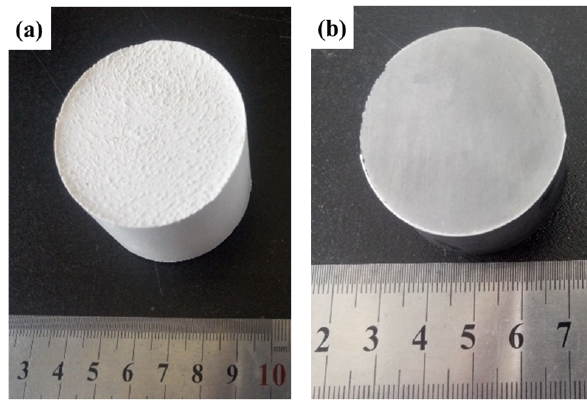
Figure 1: Optical photos of typical samples in the present work. (a) Porous Al 2 O 3 scaffold, (b) Lamellar Al 2 O 3 p/Al